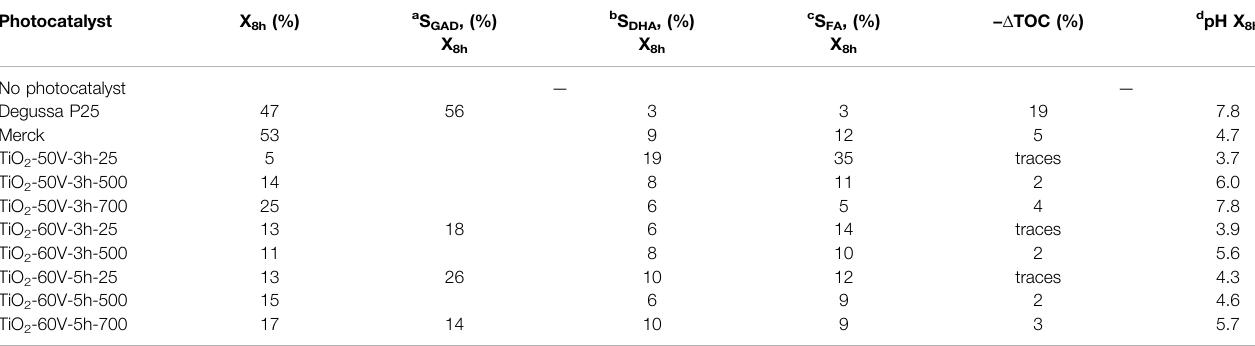
No photocatalyst — — Degussa